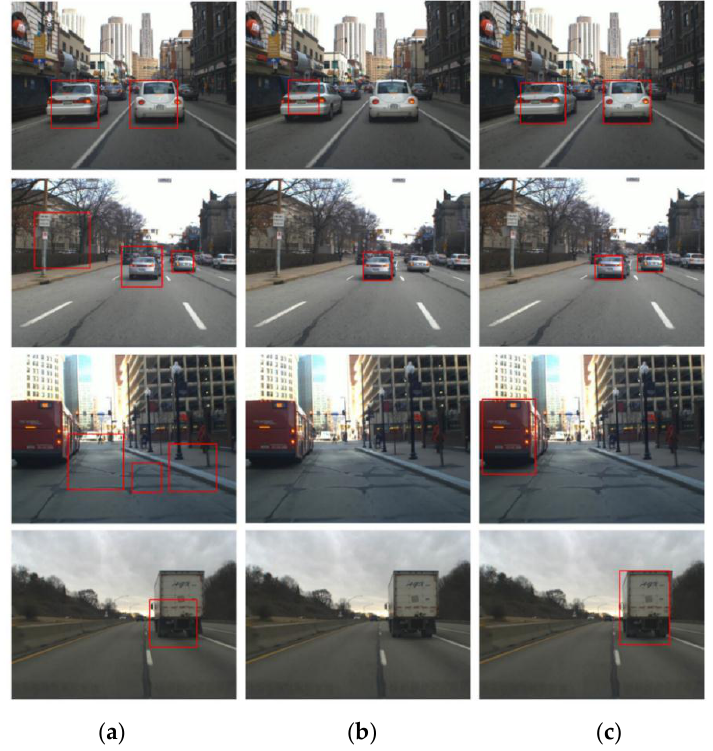
Figure 12. The vehicle detection result of ( a ) “SW”; ( b ) “Alonso”; and ( c ) “SHE+VH”.